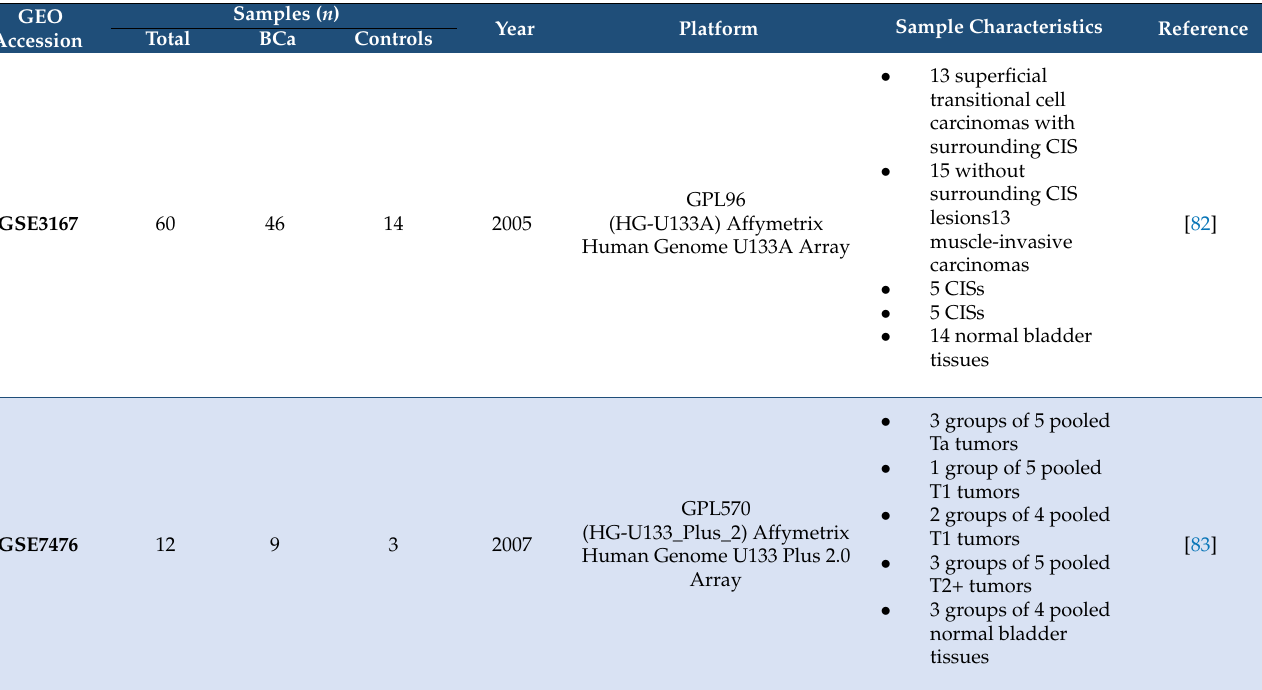
Table 1. Characteristics of the 18 individual series included in the integrative